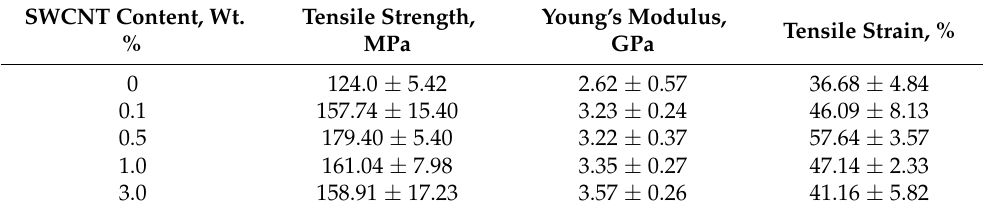
Table 1. Mechanical characteristics of the chitosan-based composite films containing SWCNT. Table 2. Mechanical characteristics of the pure chitosan film and the composite film containing SWCNT Content, Wt. 3.0 wt.% of SWCNT measured in physiological solution. SWCNT Content, Wt.